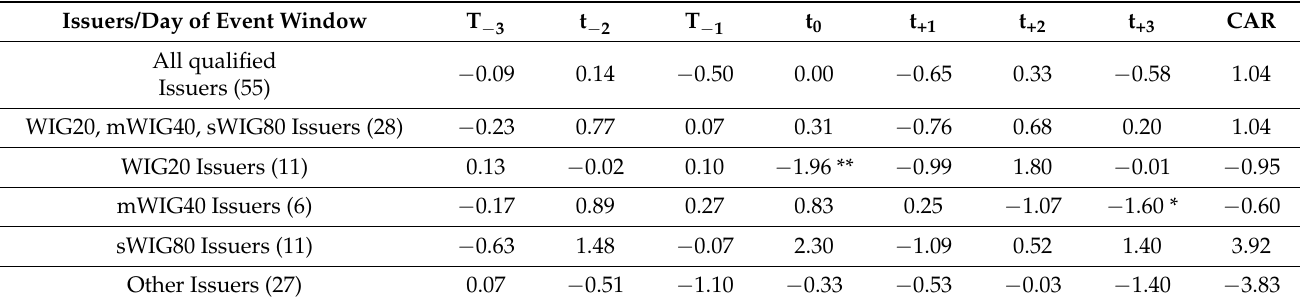
Table 3. Cross-section analysis of AAR for each qualified case of reporting IoA by issuers from the WIG index in year 2020 (in percentage